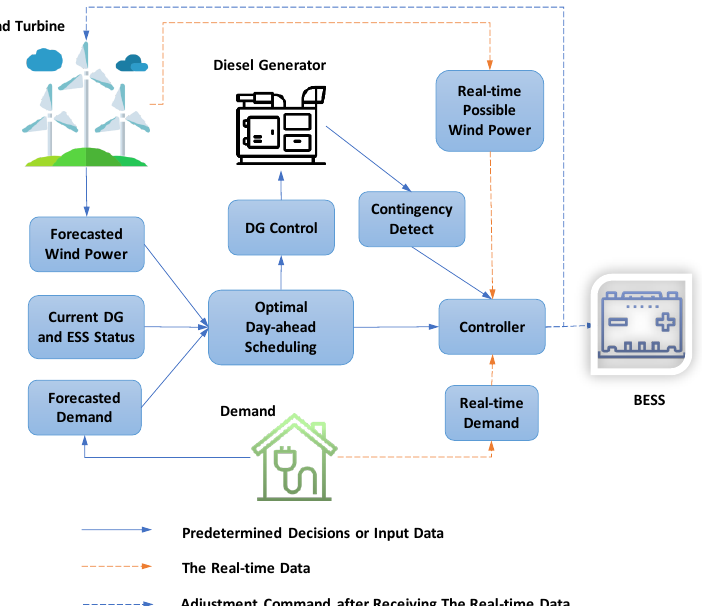
Figure 2. Schematic illustrating the optimal scheduling problem for an islanded power system.